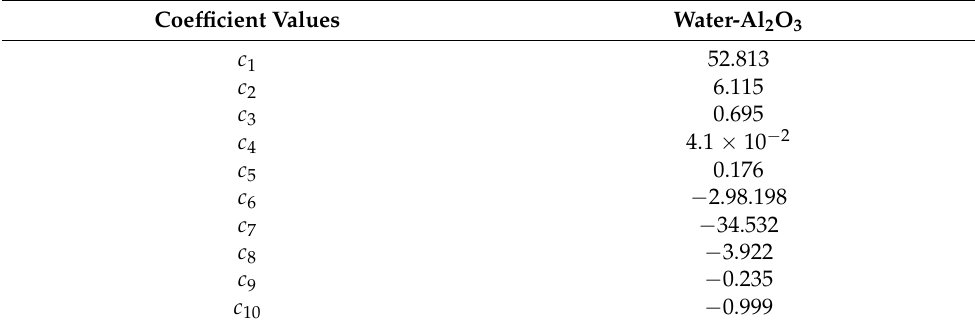
Table 2. Constants of water-Al 2 O 3